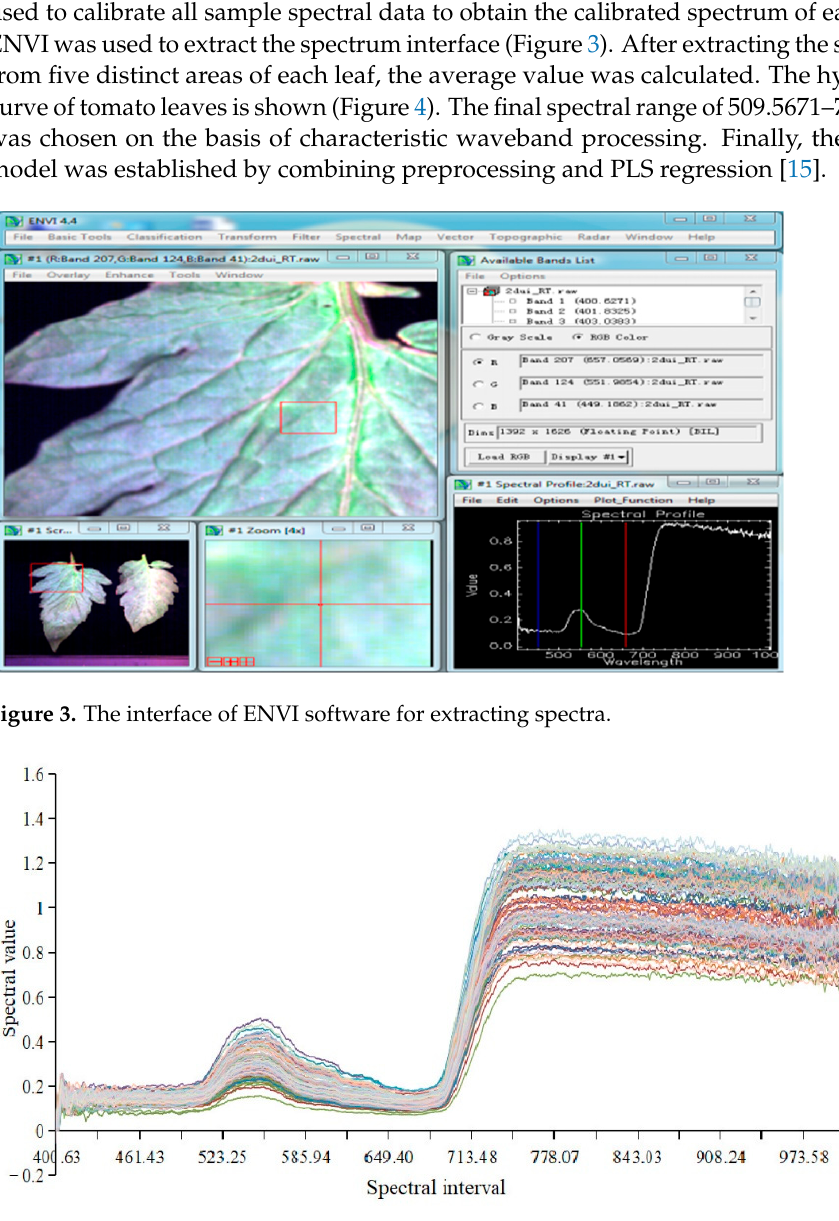
Figure 4. Hyperspectral data of tomato leaves.